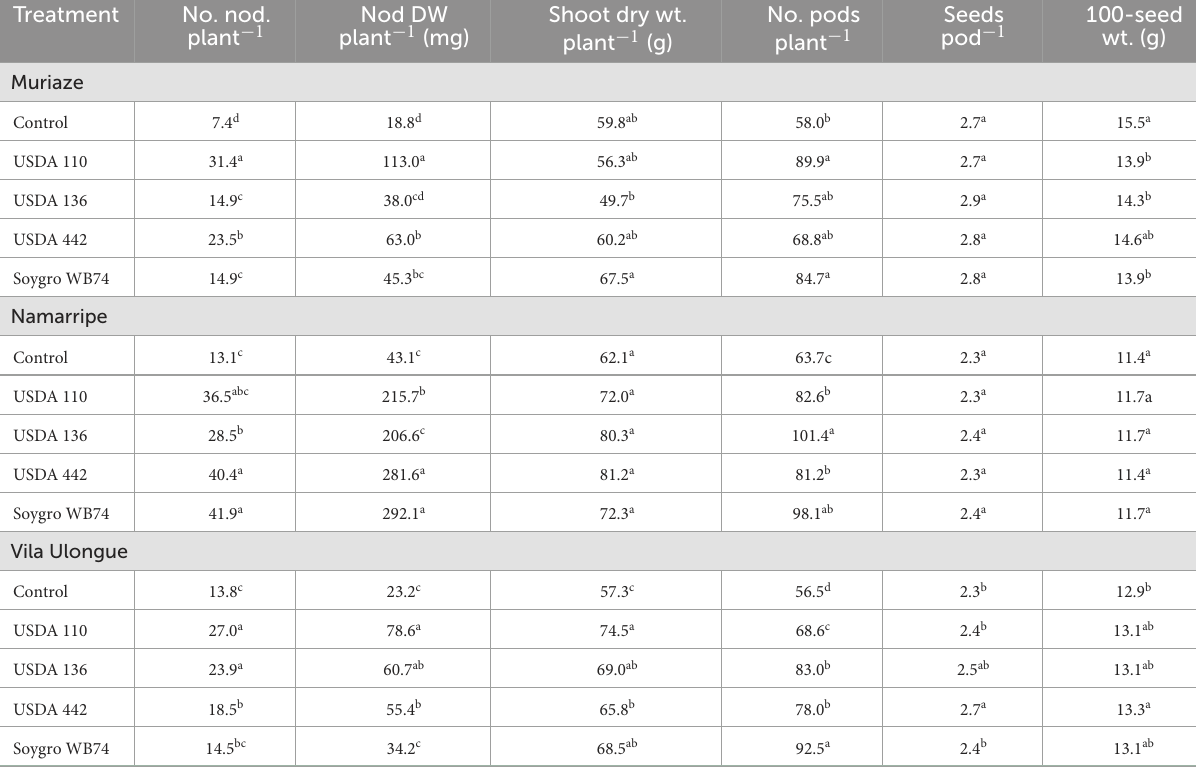
TABLE 2 Effects of inoculation on number and dry weight of nodules, shoot dry weight at R3 stage, number of pods, seeds per pod and 100-seed weight at Muriaze, Namarripe, and Vila Ulongué in 2017/2018 cropping season. Treatment